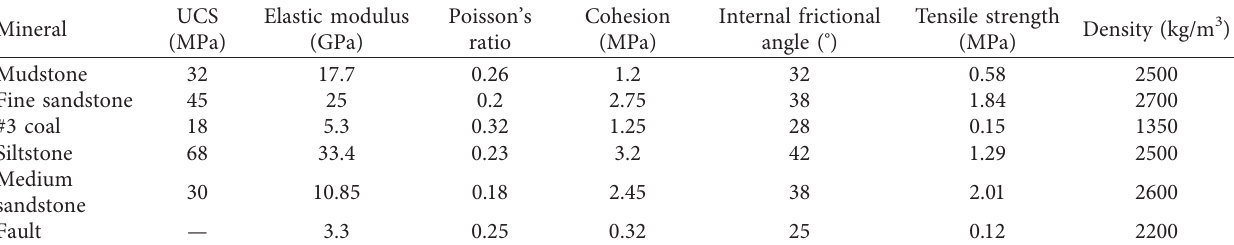
Table 1: Mechanical parameters of the model.